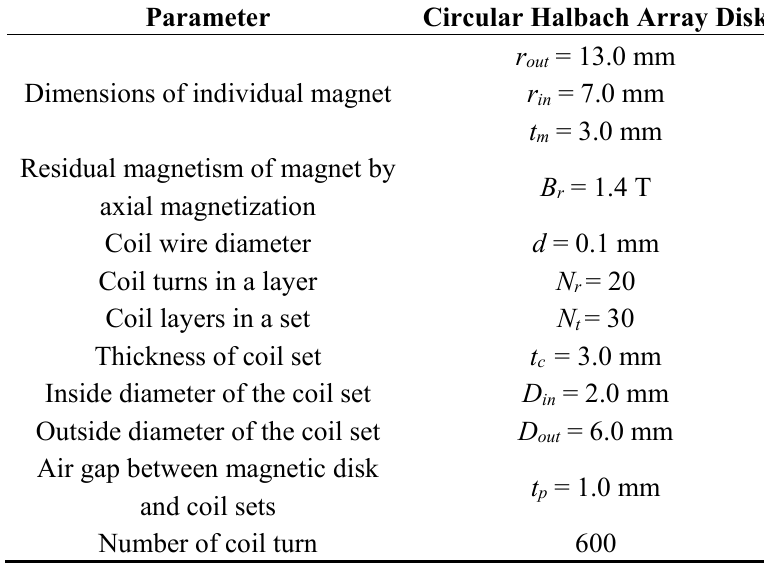
Figure 8. Peak value of electromotive force for magnetic disks with different sector angle ratios r m . Table 1. Parameters of the magnets and